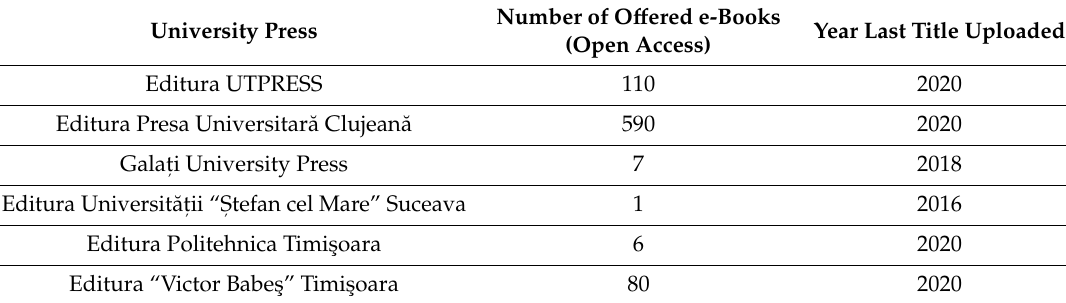
Table 6. Dynamics of e-books (open access) in